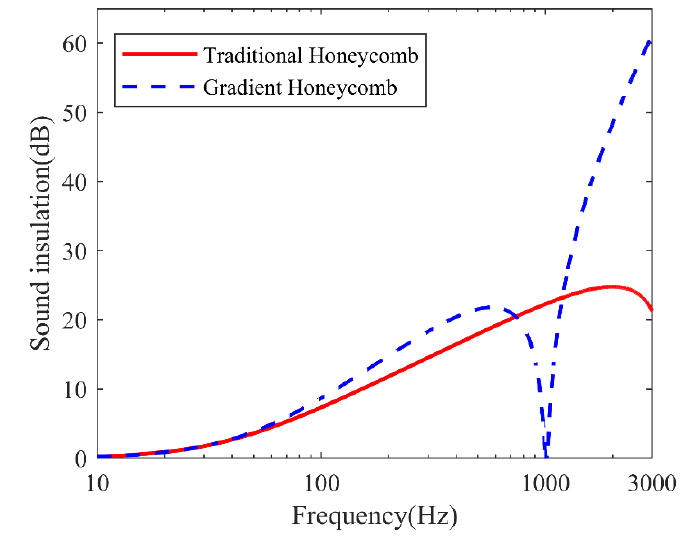
Figure 11. Comparison of sound insulation between traditional and gradient honeycomb.